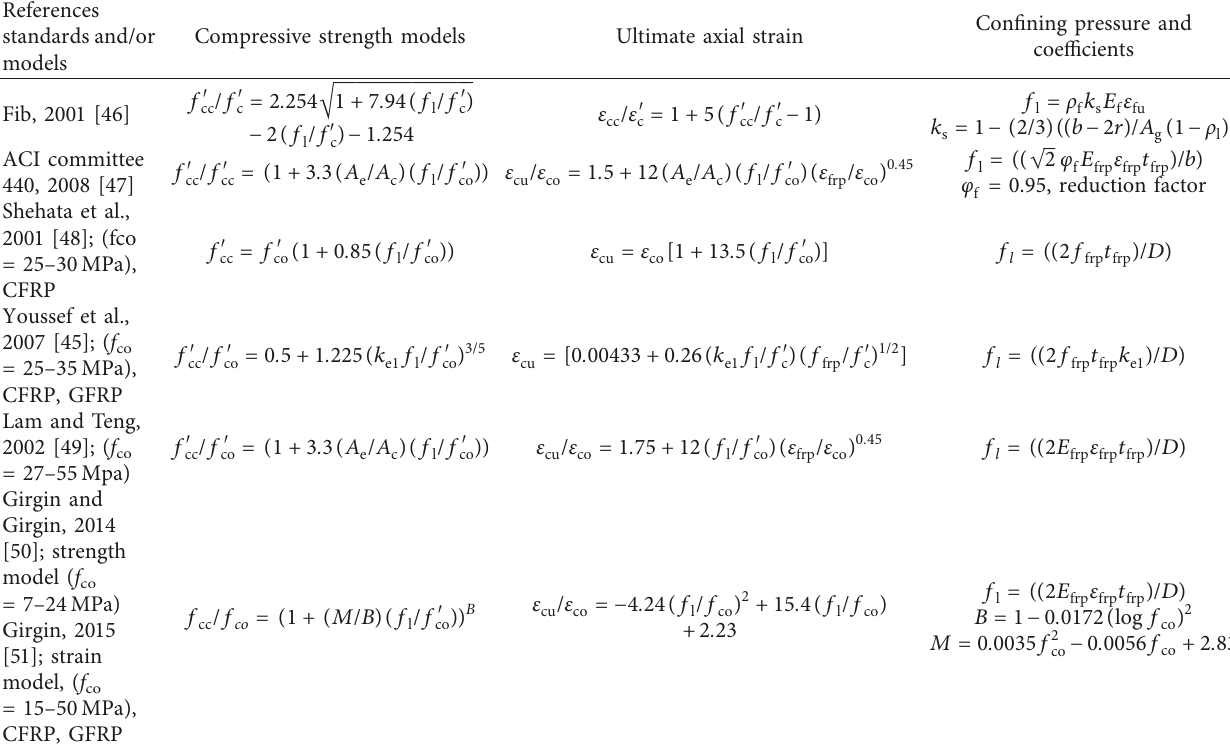
Table 5: Confined concrete models for square concrete columns.